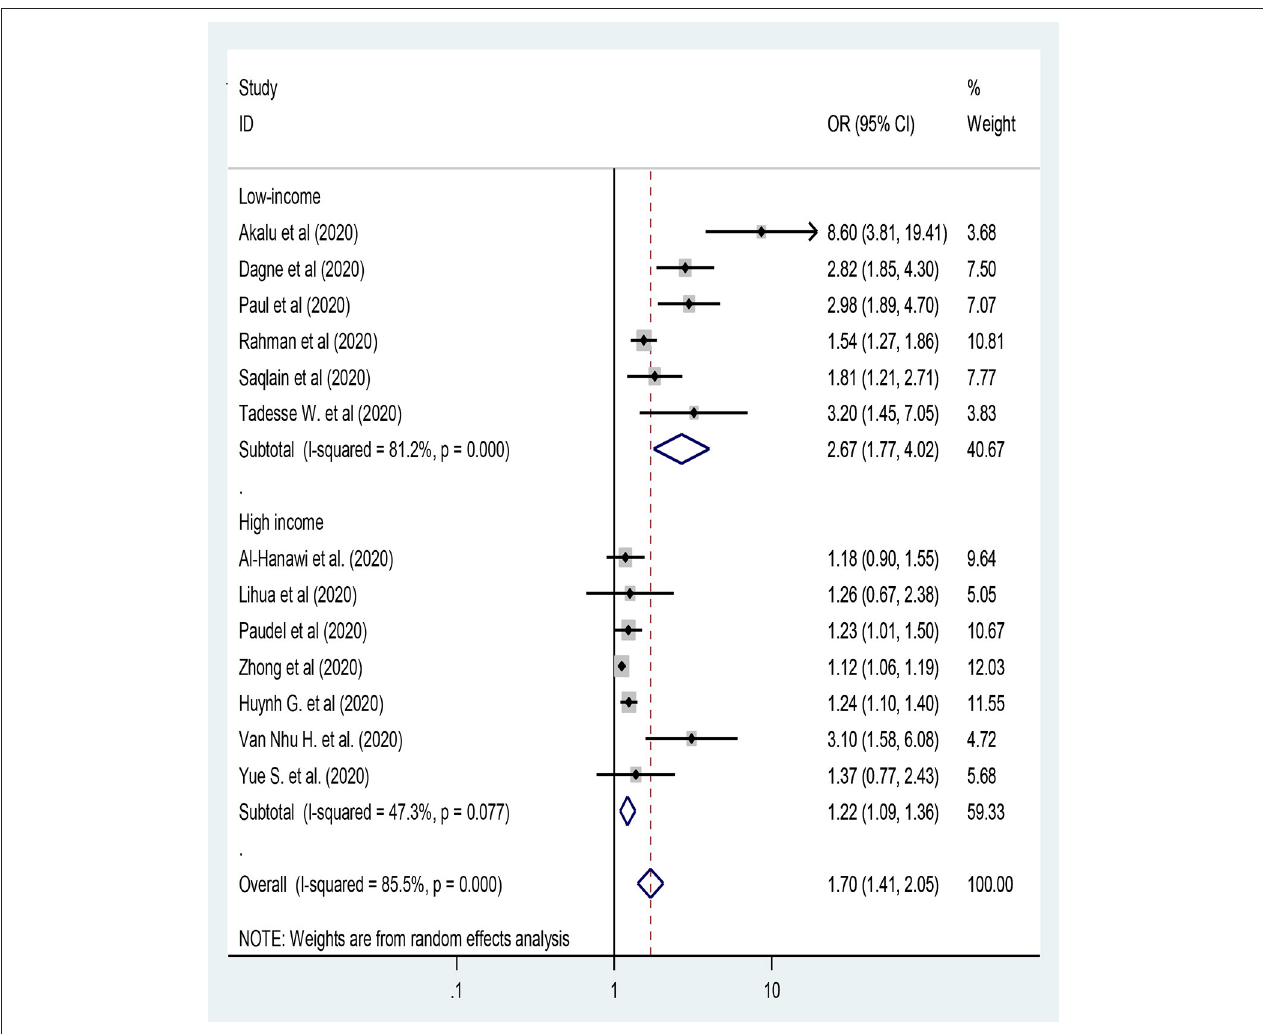
FIGURE 5 | The knowledge level of the participants and practice toward